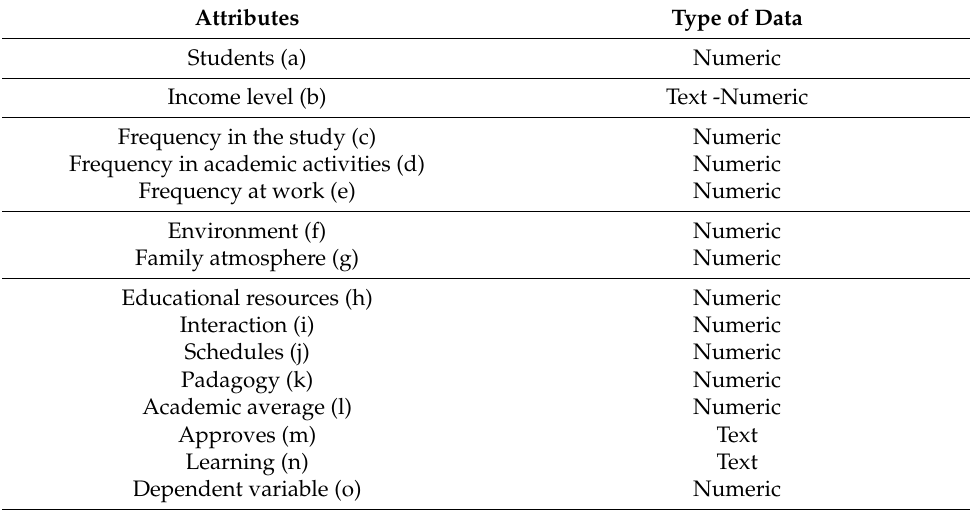
Table 1. Structure of attributes assigned to the generated analysis in the